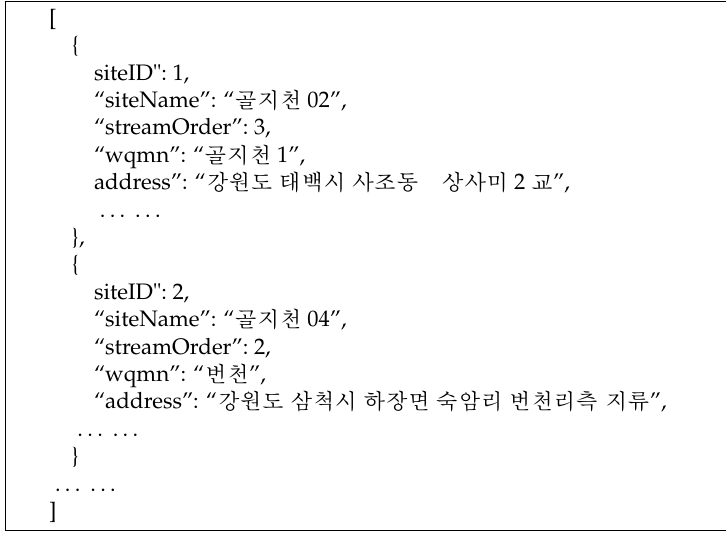
Algorithm 7. Representation for the Site collection resource.